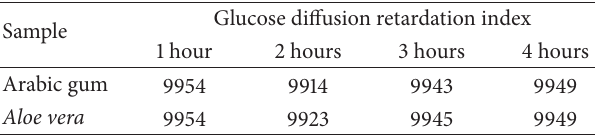
Table 3: Glucose diffusion retardation